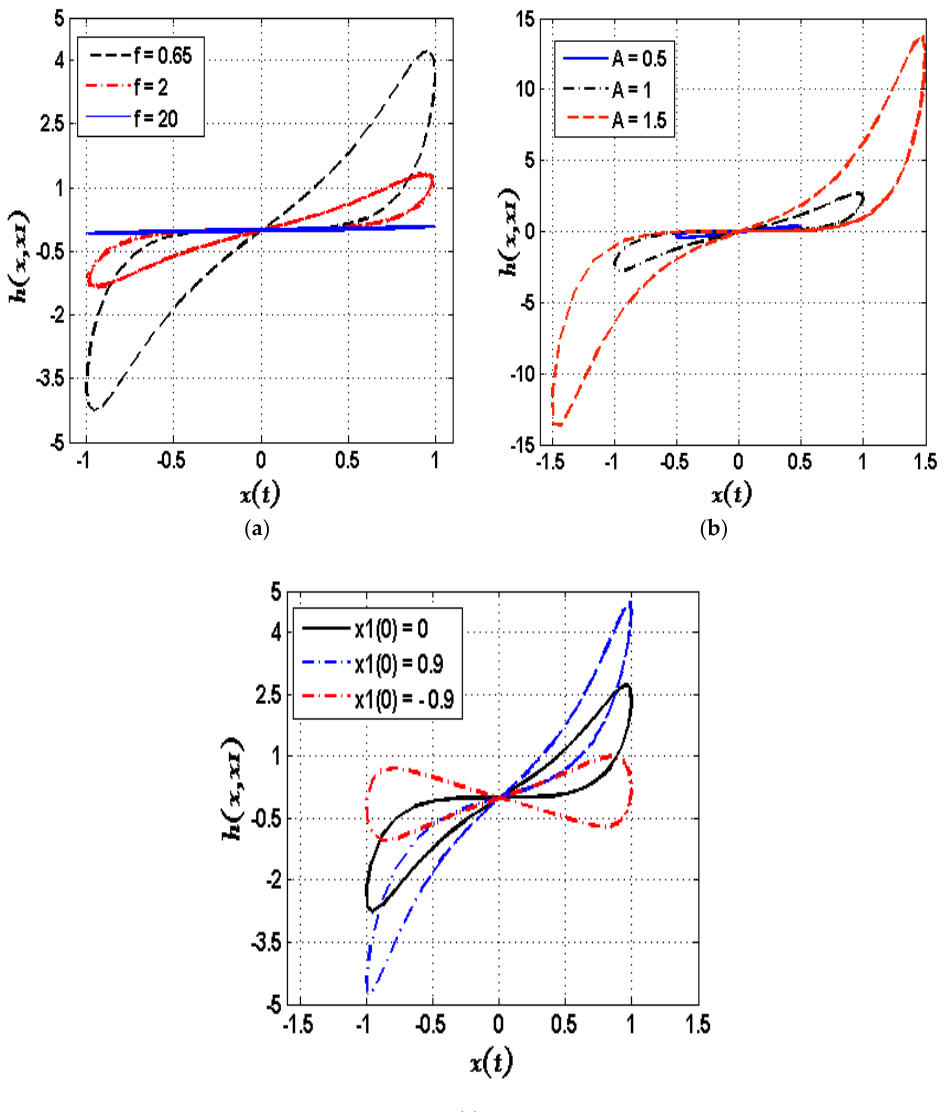
Figure 1. The memristive hysteresis loop: ( a ) x 1 (0) = 0, amplitude (A) of driven sinusoidal signal = 1, and different frequencies (f); ( b ) x 1 (0) = 0, frequency = 1, and different amplitudes. The memristive hysteresis loop (continued): ( c ) frequency = 1, amplitude = 1, and different initial conditions of x 1 ( t ).